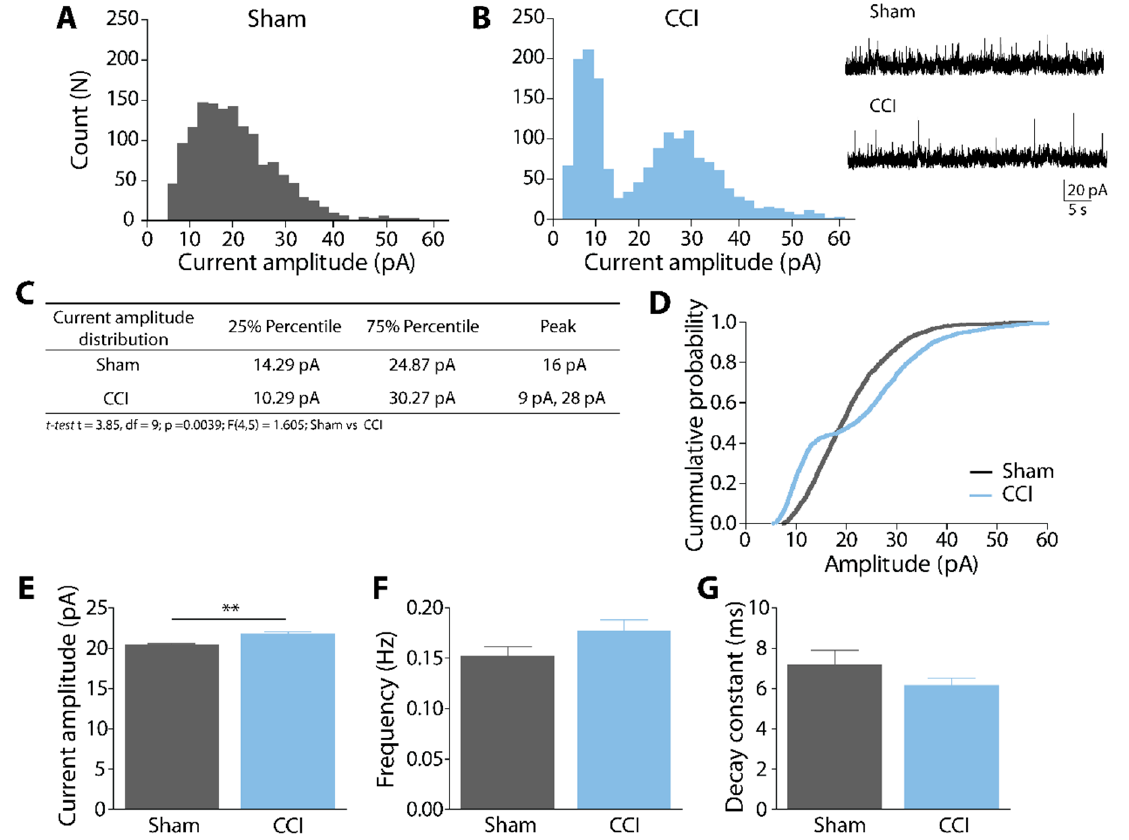
Figure 2. Glycinergic currents (sIPSCs) in CeA slices of CCI show a bimodal current amplitude distribution. ( A , B ) Spontaneous current amplitude distribution plots for Sham ( A ) and CCI ( B ) animals. Inset: representative synaptic sIPSC glycinergic currents in the presence of CNQX (10 μ M), APV (50 μ M), bicuculline (10 μ M), clamped at +20 mV. ( C ) the table summarizes the distribution data from ( A , B ). ( D ) Cumulative probability histogram of current amplitude in CeA neurons in the Sham and CCI. ( E – G ) Comparative plots of the glycinergic sIPSC current parameters, as mean ± SEM, ** p < 0.01 (n = 5 Sham, 9 cells; n = 5 CCI, 10 cells).